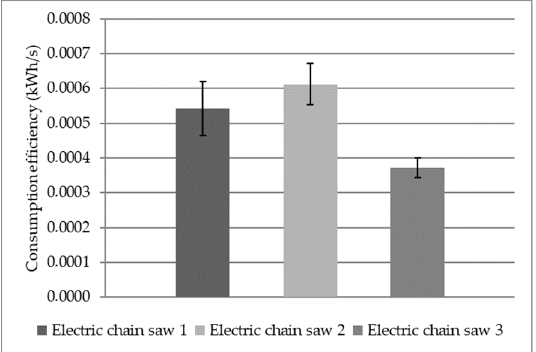
Figure 2. ( a ) Cross-cutting time and electric energy consumption by the type of electric chainsaw—mean and 95% confidence interval ( b ) Electric energy consumption by type of electric chainsaw—mean and 95% confidence interval.